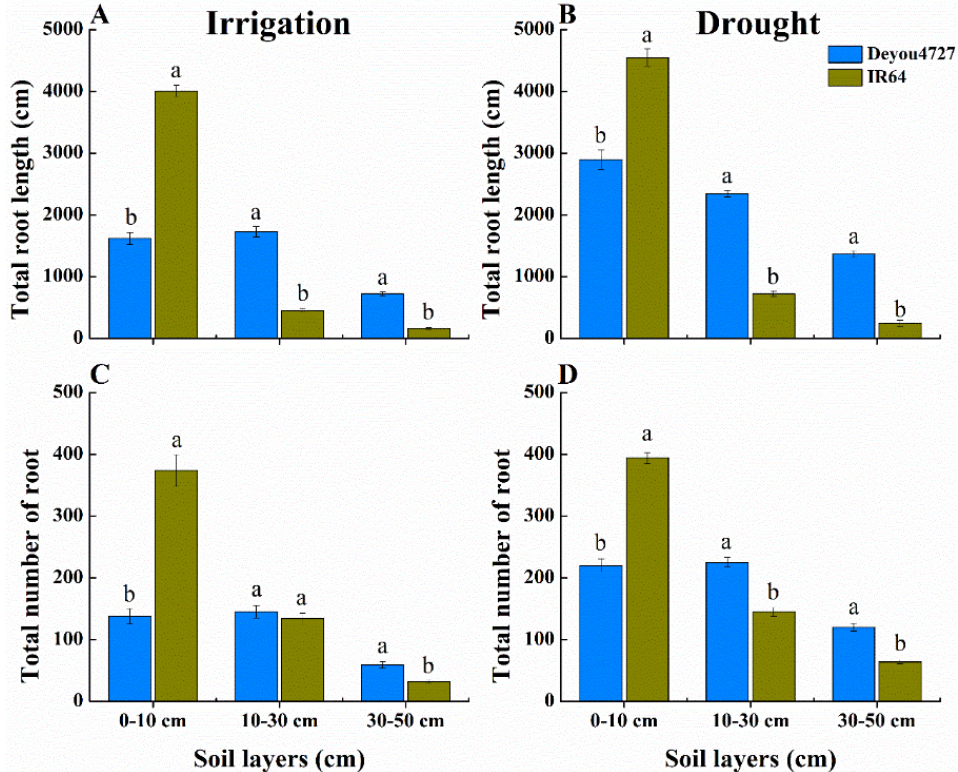
Figure 1. The comparison of the total root length ( A , B ) and total number of roots ( C , D ) among different soil layers of Deyou4727 and IR64 under irrigation and drought conditions. The values in each graph represent the Mean ± SE (standard error) of 3–6 replicates, and lowercase letters indicate significant differences between varieties and treatments, at p < 0.05.